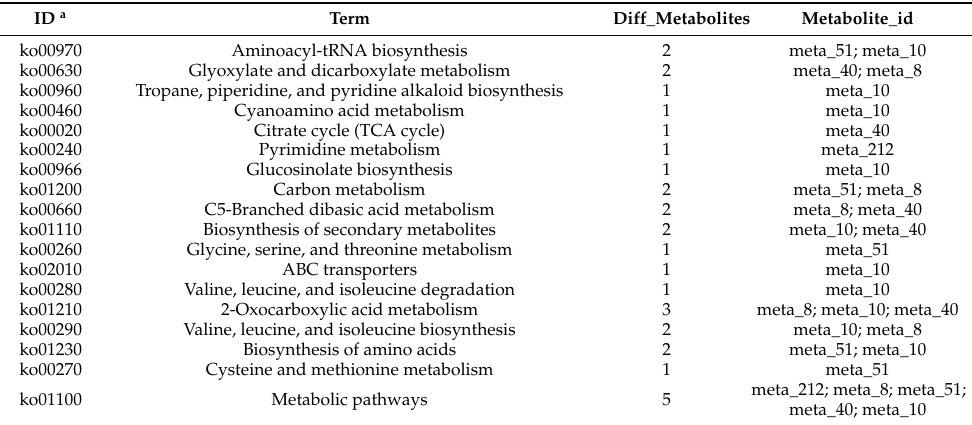
Figure 6. Heatmap of all differentially accumulated metabolites for H24h. CK, the control group; H24h, the 24 h heat stress group. Table 5. KEGG classification of significantly enriched pathways, following metabolite analysis of differentially accumulated